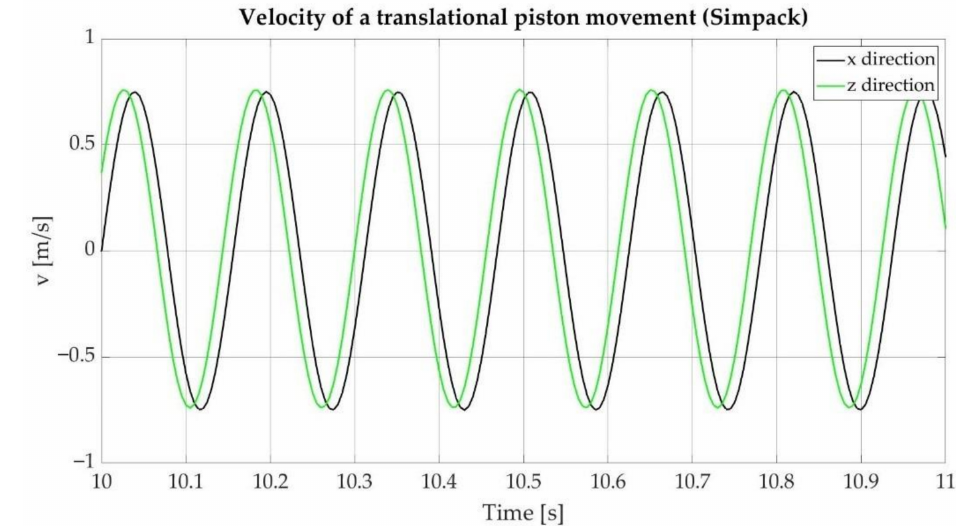
Figure 10. Translational velocity of pistons—results from